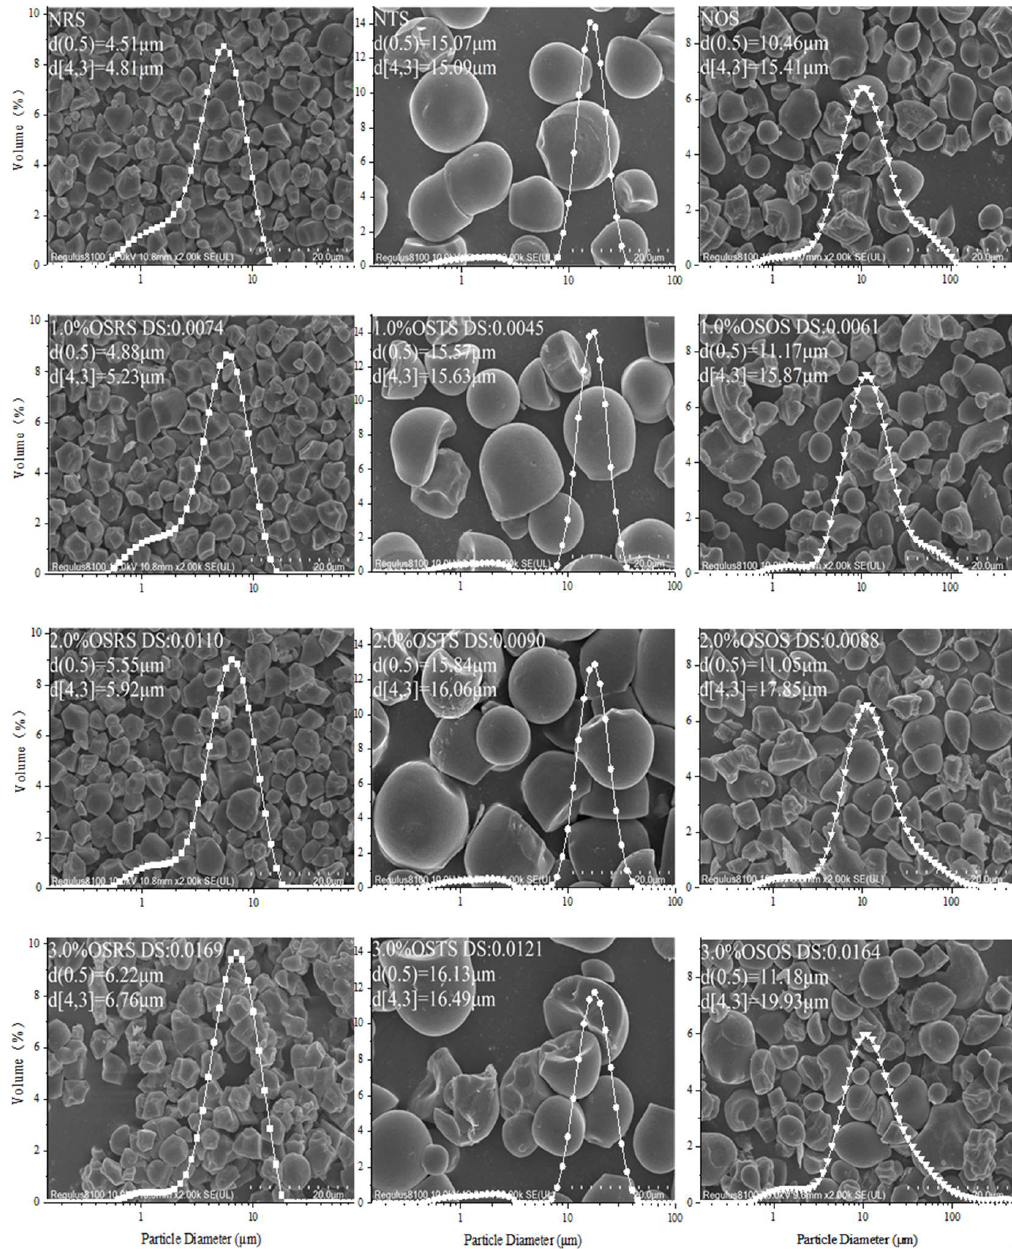
Figure 3. SEM and PSD of NS and